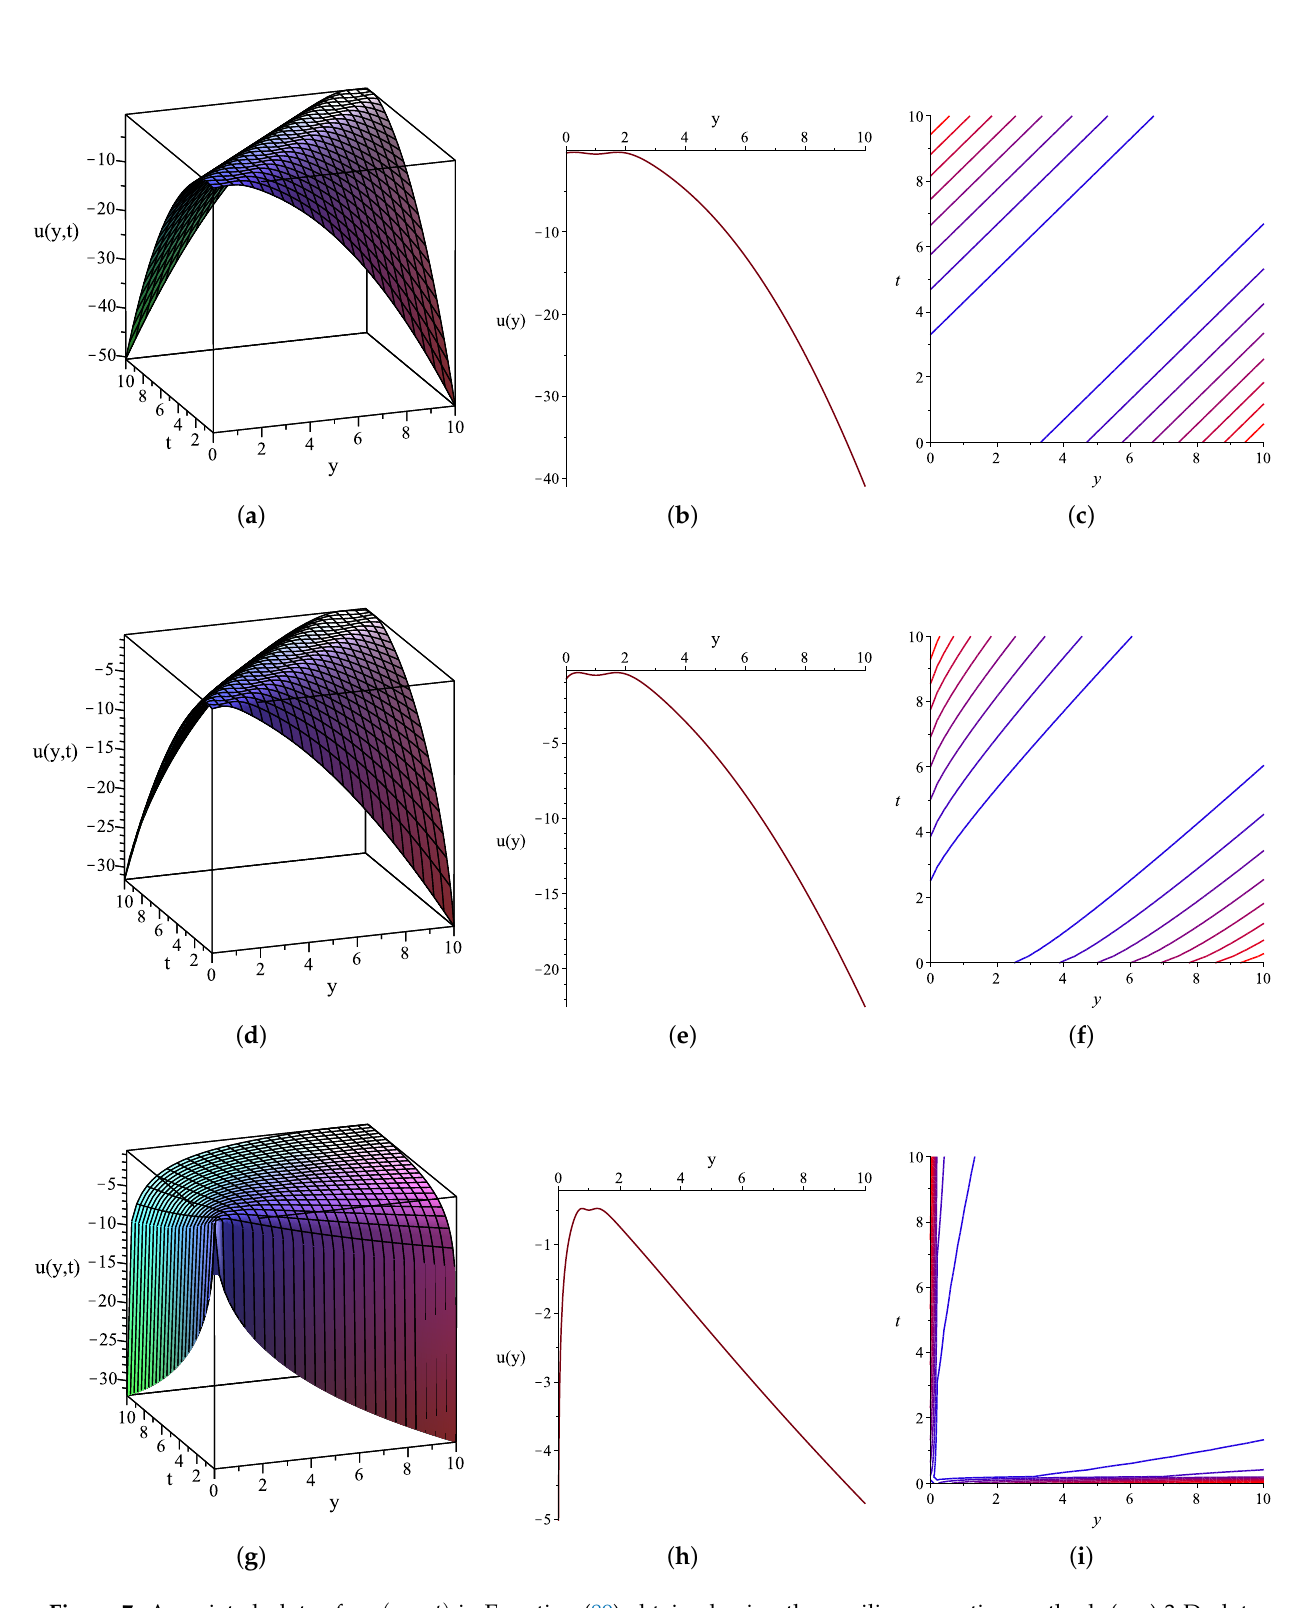
Figure 7. Associated plots of u 12 ( x , y , t ) in Equation (89) obtained using the auxiliary equation method: ( a – c ) 3-D plot, 2-D plot and contour plot, respectively when α = 1; ( d – f ) 3-D plot, 2-D plot and contour plot, respectively when α = 0.8; ( g – i ) 3-D plot, 2-D plot and contour plot, respectively when α =